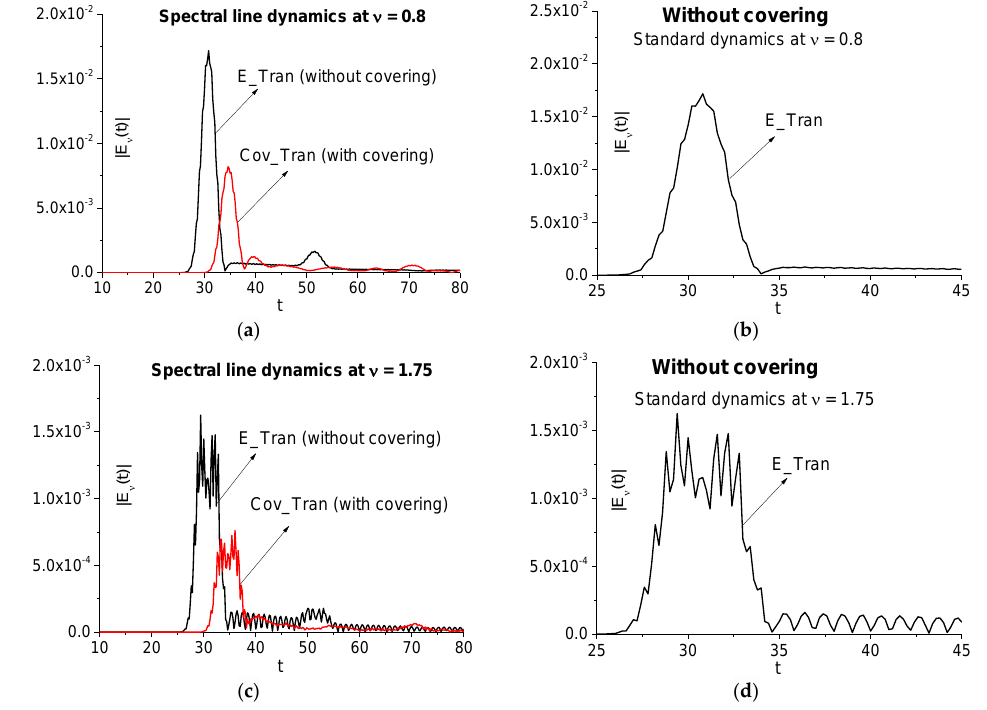
Figure 18. Spectral line dynamics at the frequencies ν = 0.8 ( a ), 1.75 ( c ) for the signals transmitted through the medium without covering (E_Tran) and with covering (Cov_Tran) in the time interval t = [10, 80] ( a ), ( c ); [25, 45] ( b ), ( d ).